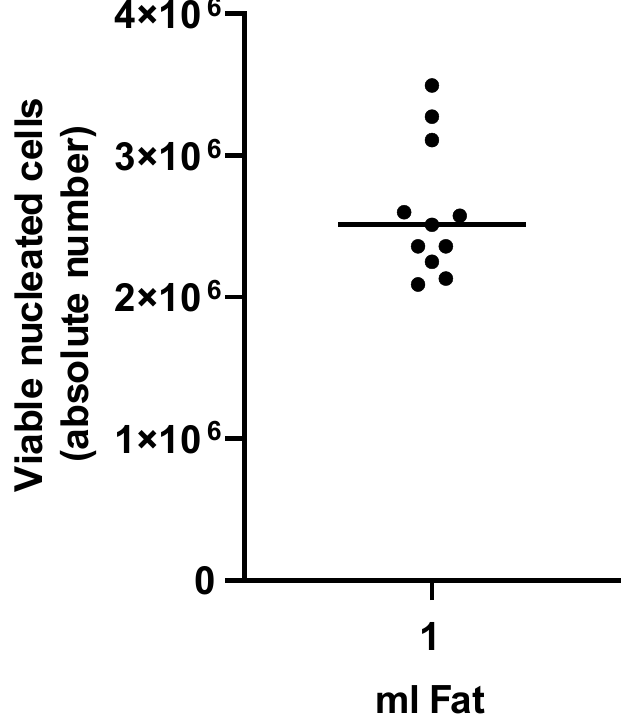
Figure 1. Number of viable nucleated cells per mL tissue-like stromal vascular fraction (tSVF). Each dot represents the value of one donor.